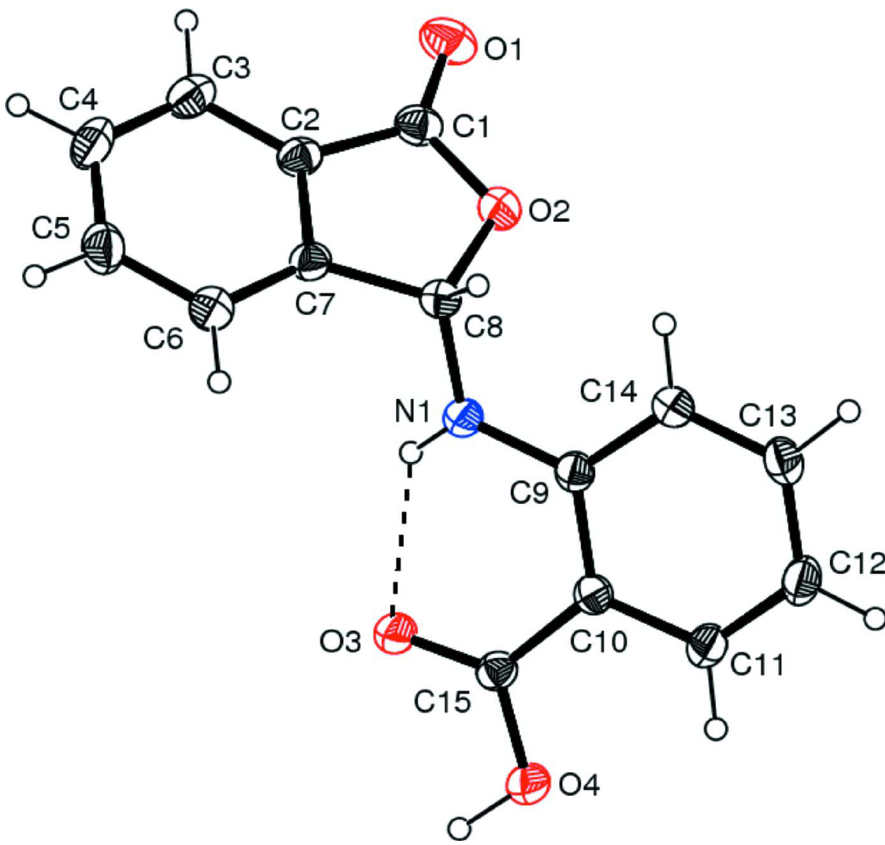
Figure 1 The molecular structure of the title molecule, with the atom-numbering scheme. Displacement ellipsoids are drawn at the 30% probability level. Hydrogen bond is shown as dashed